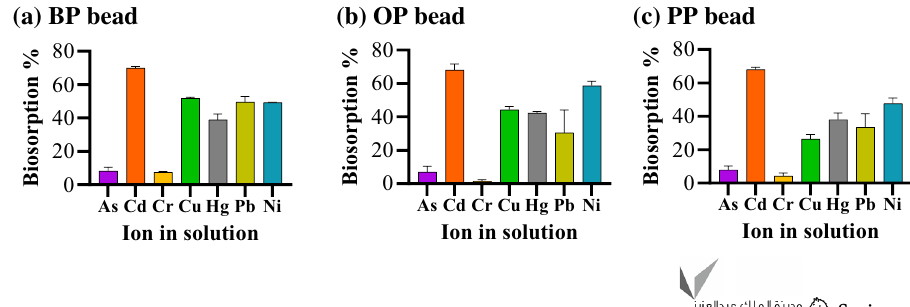
Size before biosorp- Size after biosorp- tion (µm × µm) tion (µm × µm)